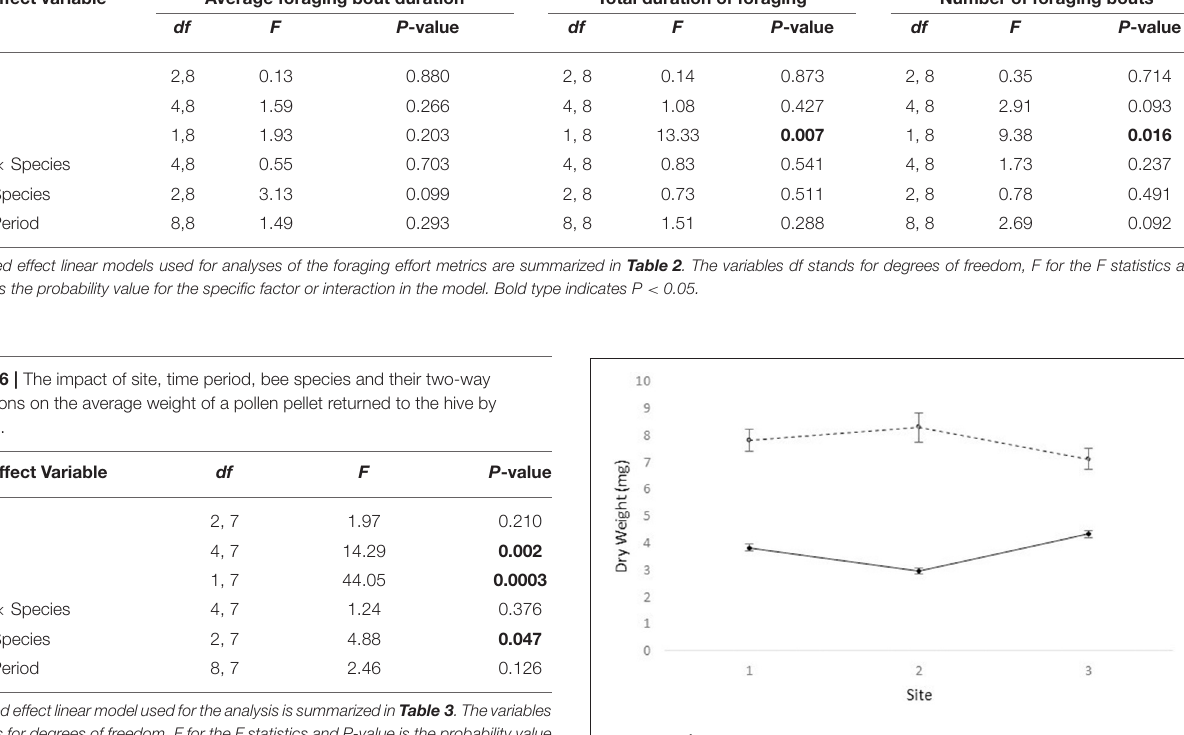
Individual bee level